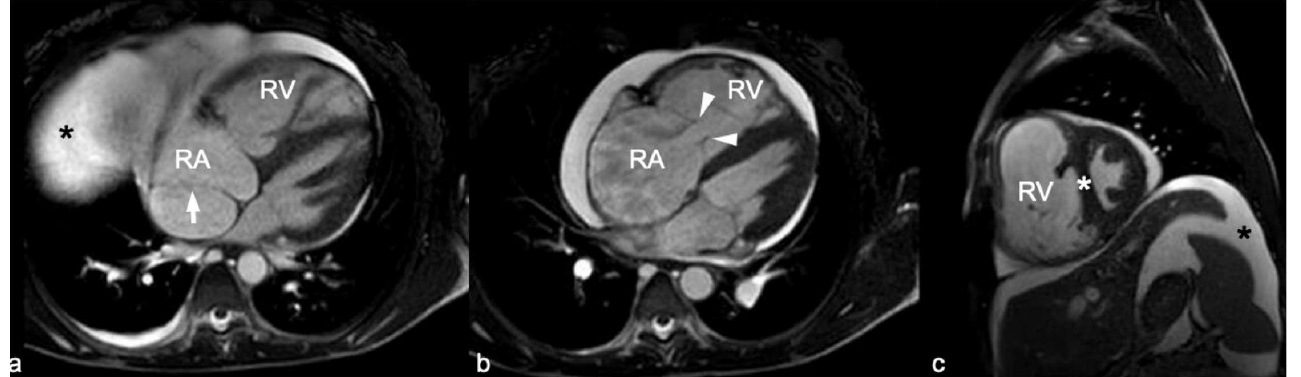
Figure 3. SSFP Cardiac MR images in the 4 chamber ( a , b ) and short axis ( c ) planes. RV and RA are severely dilated and diastolic septal shifting (white asterisk on c ) as a sign of volume overload of the RV are seen. The eustachian valve is seen in the RA (White arrow on a ) with no other membra- nous structures seen on more cephalic images. Severe tricuspid regurgitation with significant coap-